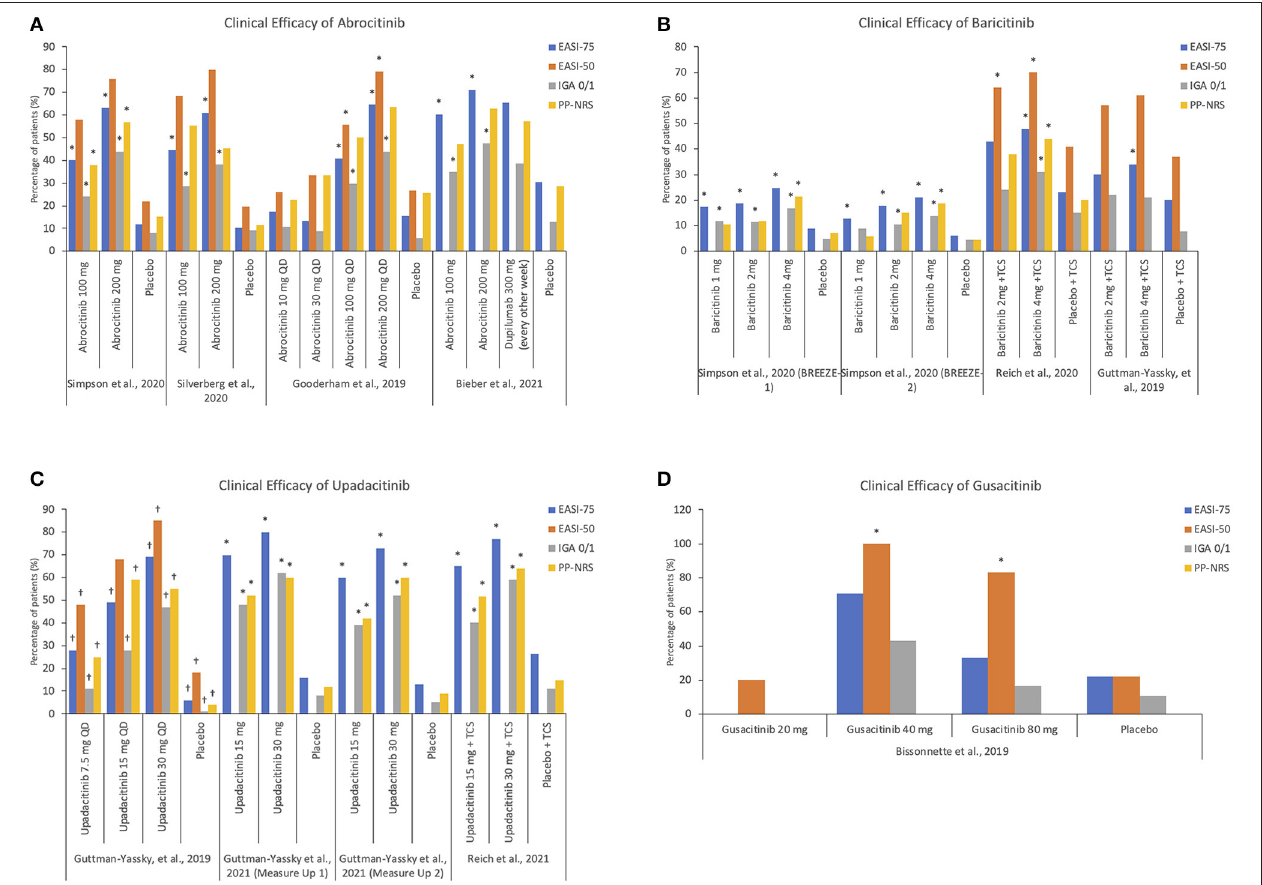
FIGURE 4 | Summary of JAKi clinical efficacy by multiple outcome measures. (A) Clinical efficacy of abrocitinib (B) Clinical efficacy of baricitinib (C) Clinical efficacy of upadacitinib (D) Clinical efficacy of gusacitinib. *Values reached statistical significance; † Values were estimated based on figures presented in the publication as exact values were not available. EASI, Eczema Area and Severity Index; IGA, Investigator’s Global Assessment; PP-NRS, Peak Pruritus Numerical Rating